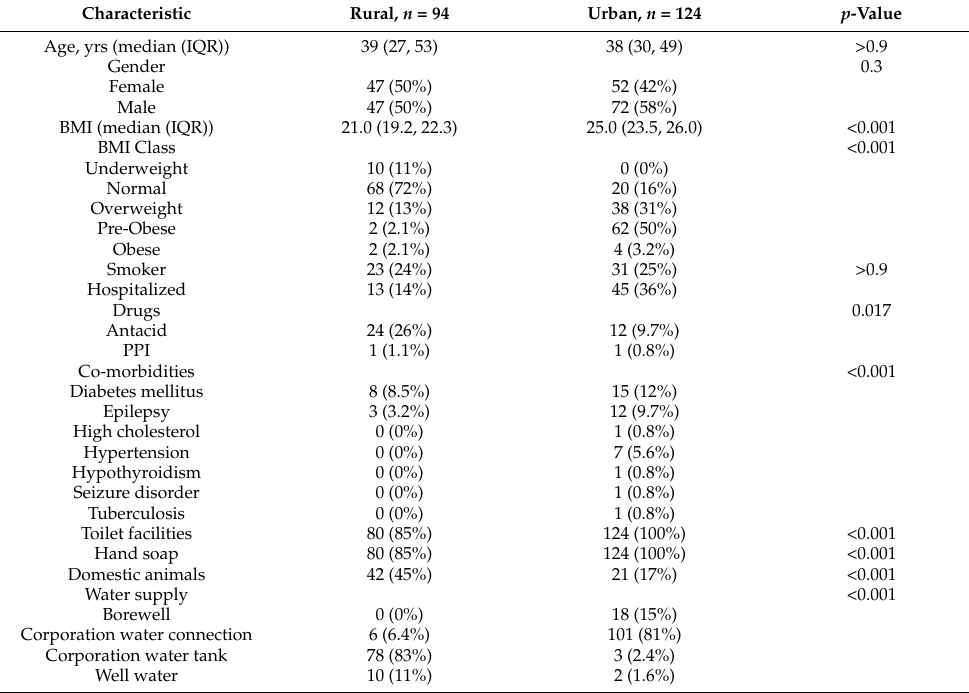
Table 1. Baseline characteristics of study population. Descriptive statistics presented as the number of samples ( n ) and percentage (%) or median (interquartile range,